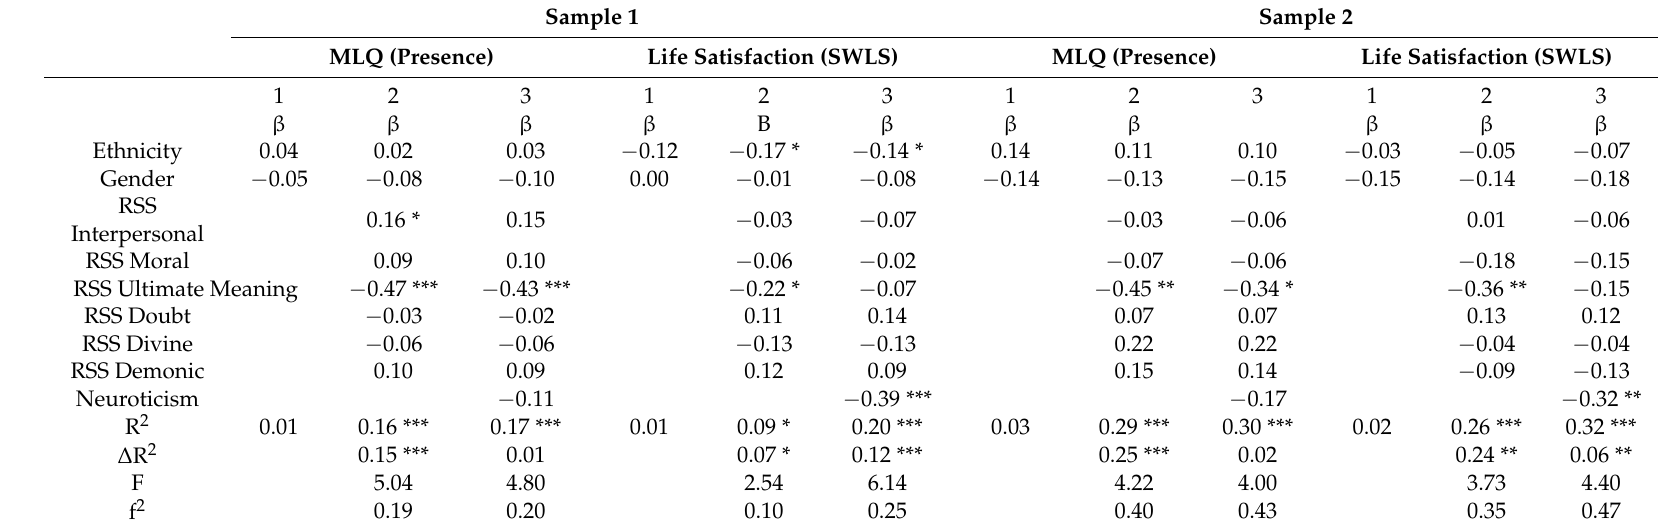
Table 6. Hierarchical Multiple Regression Predicting Well-being from R/S Struggles Among